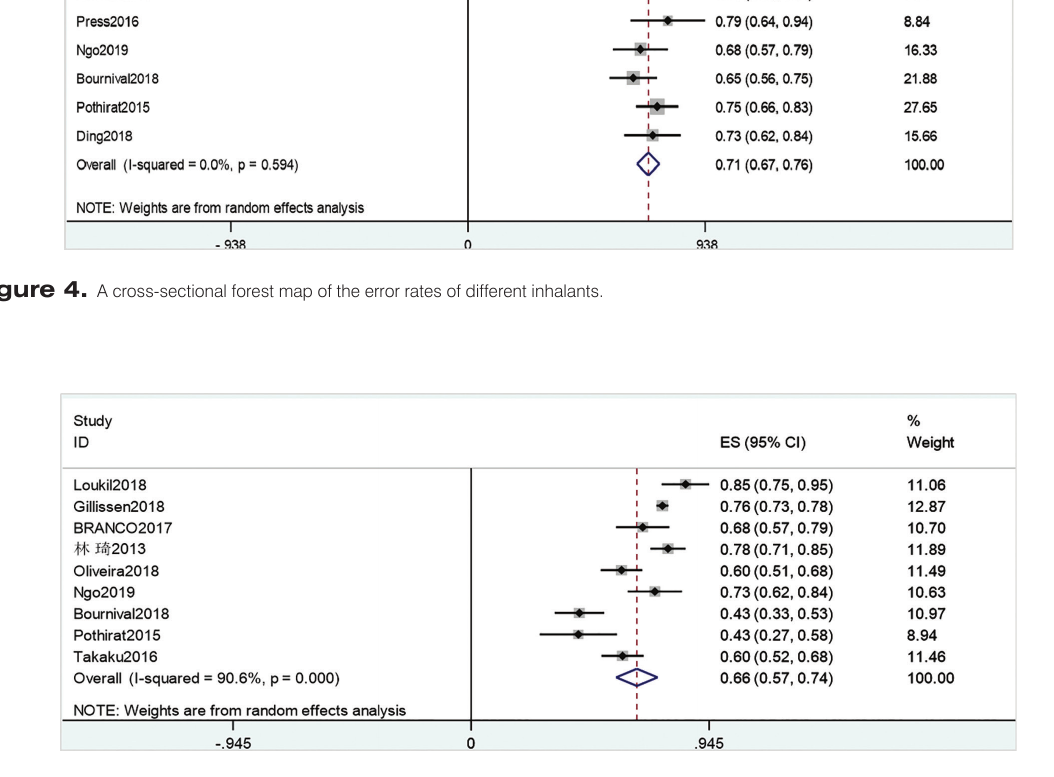
Figure 5. Forest plot of error rates for use. Abbreviation: DPI, dry powder